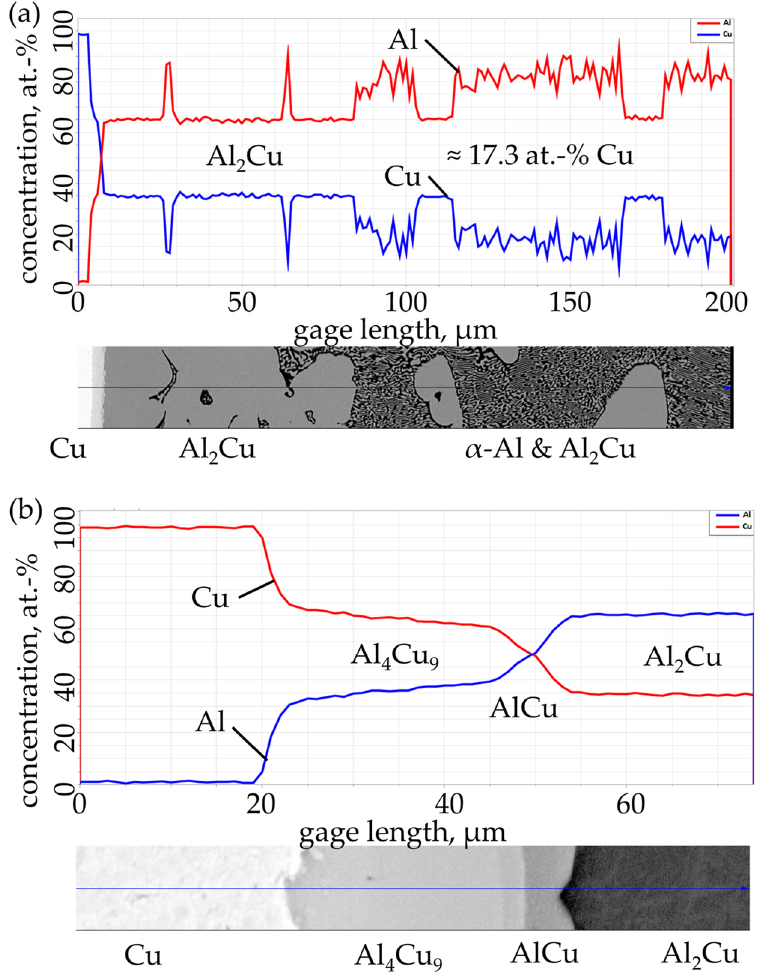
Figure 4. Representative SEM images and corresponding EDX line scans of a cast sample: ( a ) overview covering the region from Cu to α -Al, ( b ) higher magnification detail focusing on the phases present close to the Cu